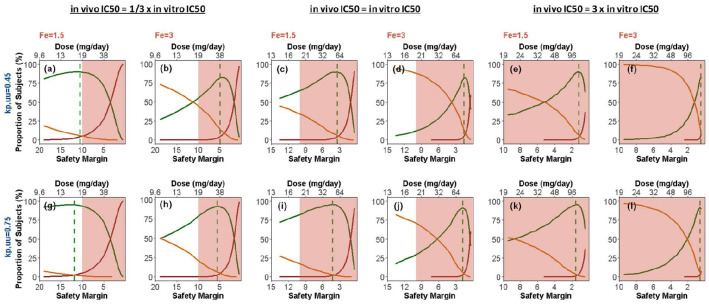
The impact of in vivo potency (IC50), brain penetration (kp,uu) and elevation of target activity (Fe) on the pharmacological response.The green, orange and red curves represent the proportions of patients in Groups A, B and C+D, respectively. The vertical lines mark the “optimal dose”, effectively the lower of 1) the dose maximizing patients in Group A and 2) the dose limiting patients in Group C+D to 5% of the population. The shaded areas represent the doses which will generate less than 10-fold safety margin.